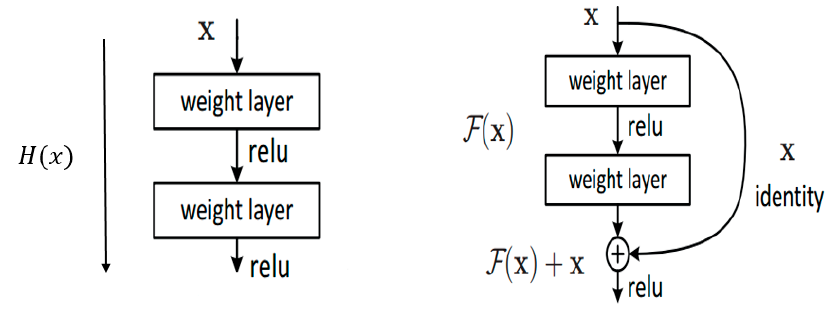
Figure 5. Normal Convolutional Neural Network ( left ); and shortcut connections of ResNet architecture ( right ) [15].